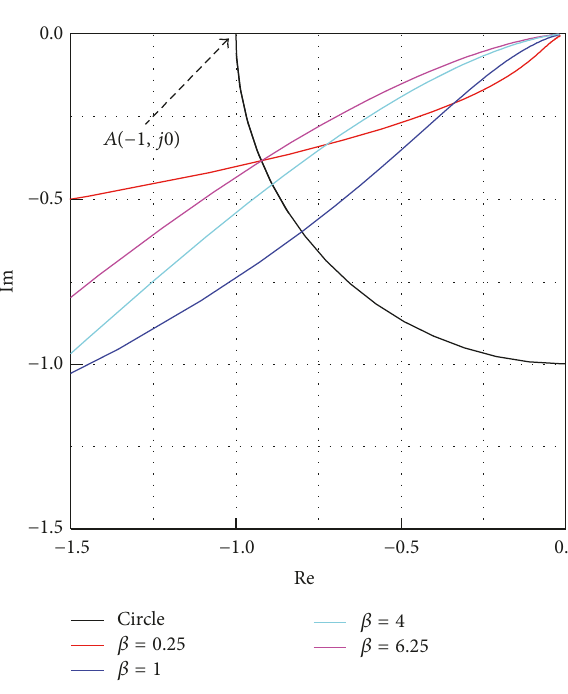
Figure 14: Nyquist diagram ( 𝛼 = 2